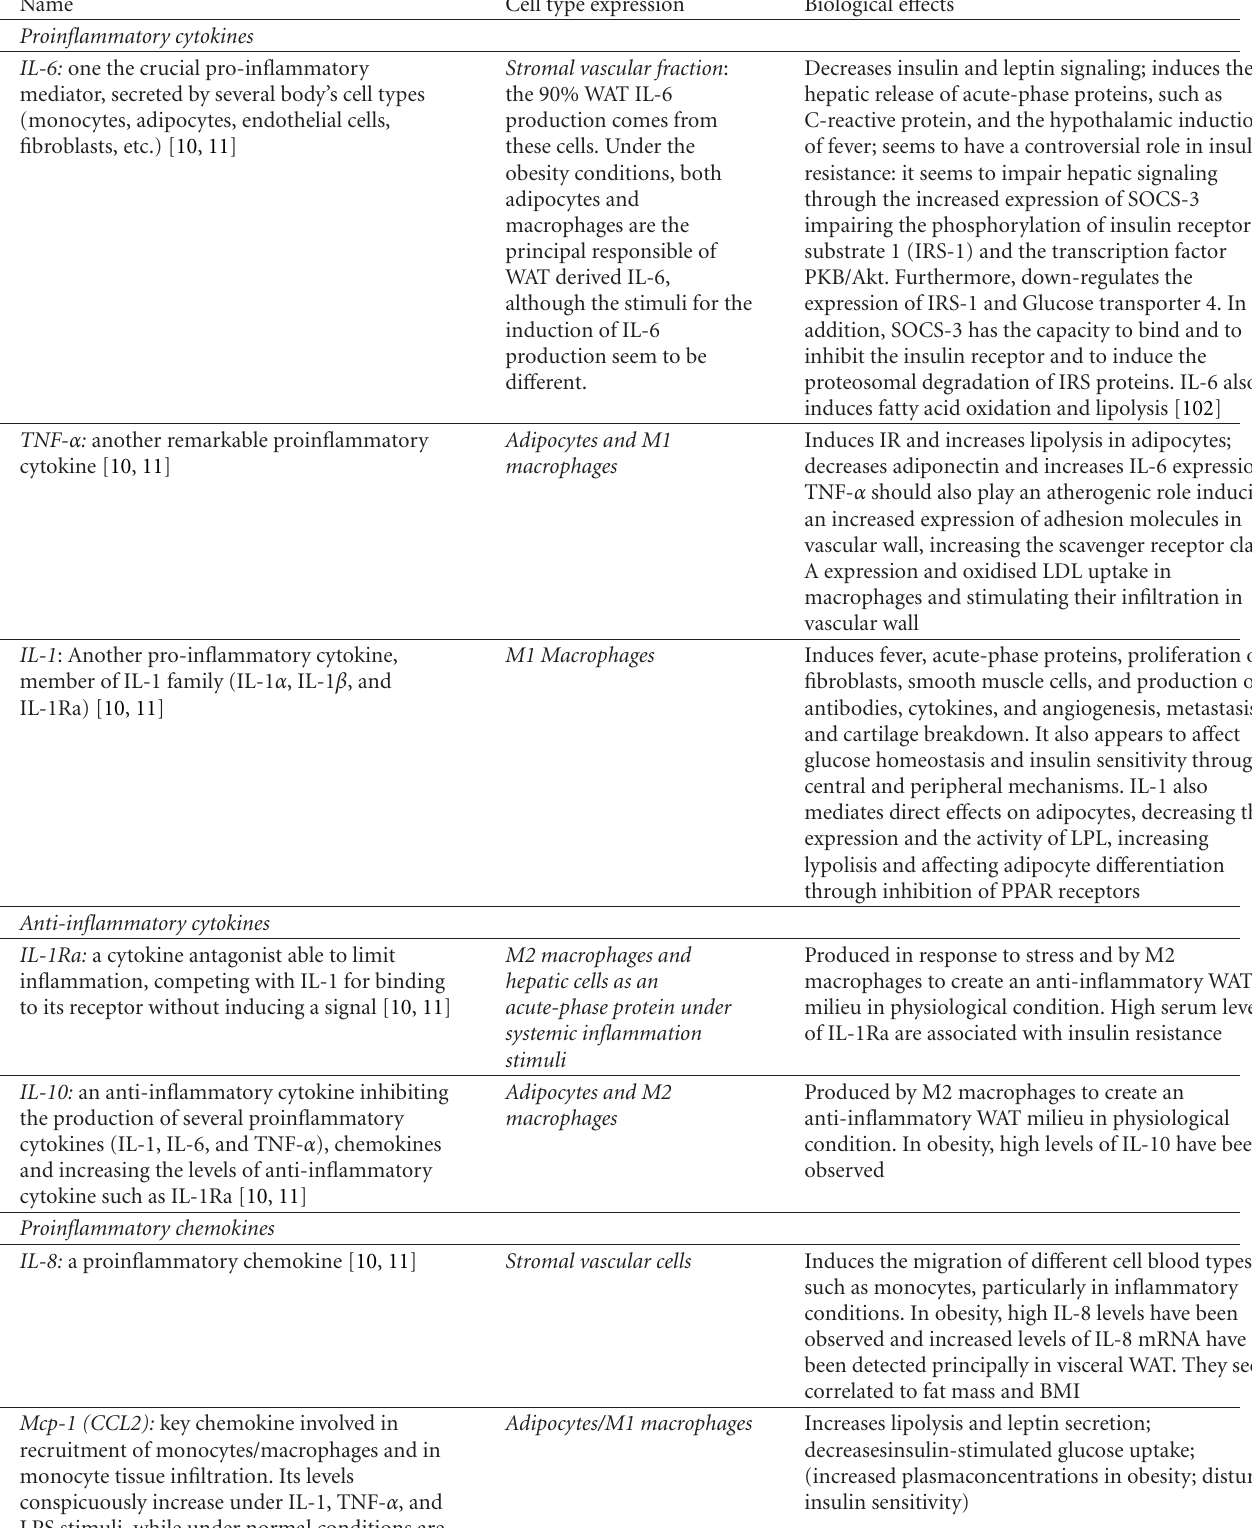
Table 2: Adipocytokines, chemokines, vascular proteins, and other proinflammatory markers produced in WAT and systemic sites and involved in the inflammatory-obesity